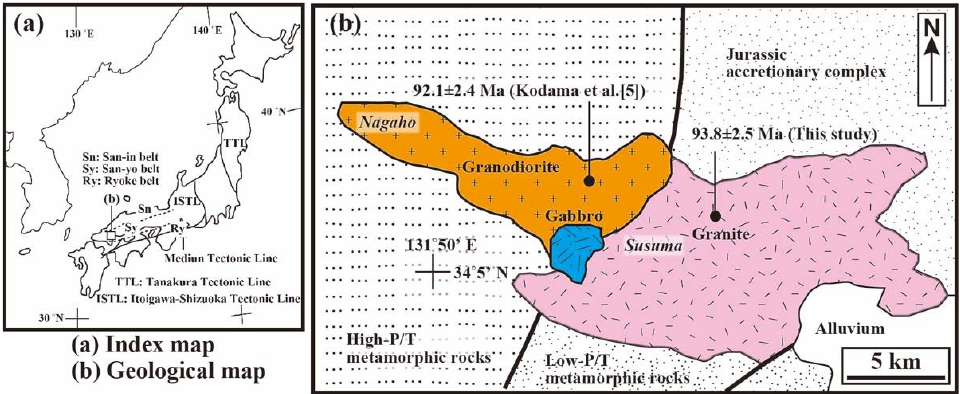
Figure 1. Geological map of the study area. ( a ) Index map with the San-in, San-yo, and Ryoke Belts. ( b ) Geological map of study area (after reference [5]). Sample sites for biotite K – Ar dating are also marked.